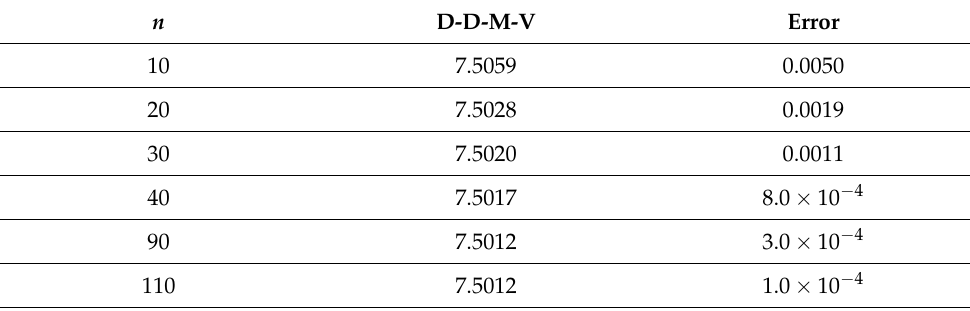
Table 3. Convergence analysis in approximating the American put price. The benchmark value, equal to 7.5009, stems from a binomial tree (C-R-R model) with n = 10,000 steps. We considered S = K = 100, T = 1, r = δ = 0.08, σ = 0.2.